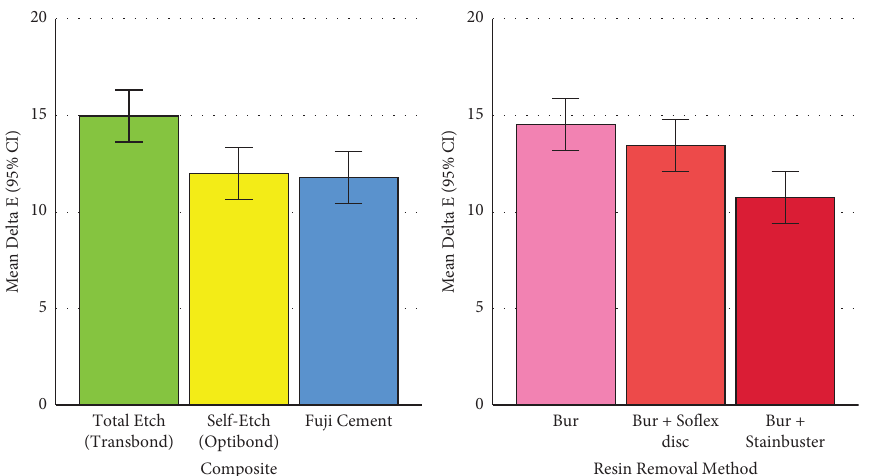
Figure 7: Means (and 95% CIs) for the Δ E parameter in 3 composites ( n � 3 × 30) and 3 adhesive removal methods ( n � 3 ×